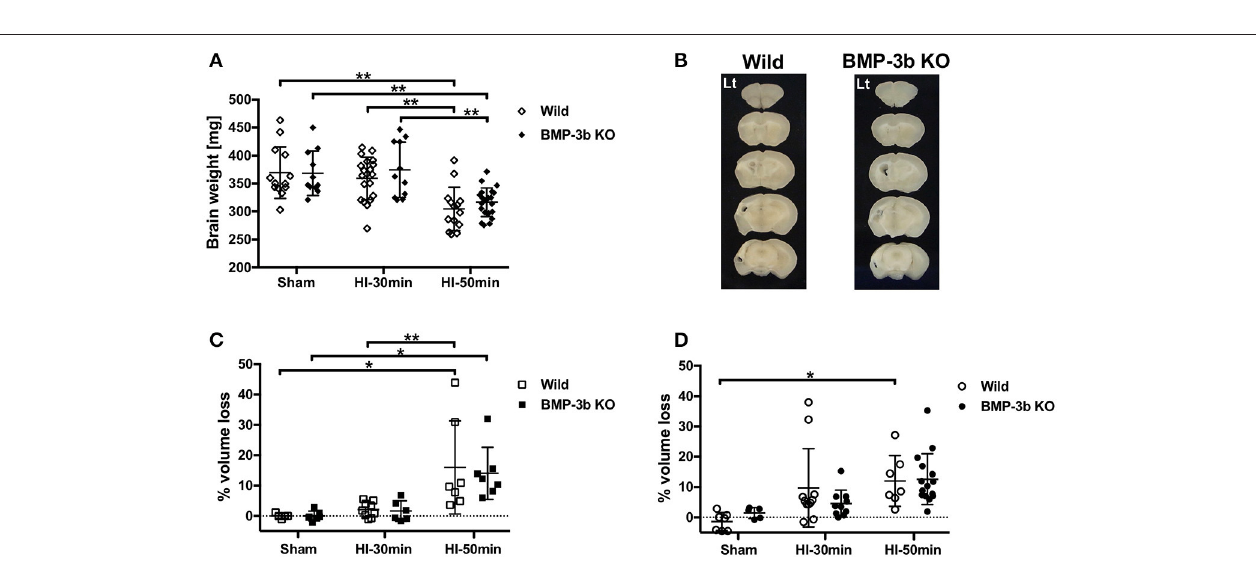
FIGURE 6 | (A) Brain weights at 14 days after surgery. (B) Representative images of 1-mm slices of brains after HI-50min insult at 14 days after the surgery. (C,D) Percent cerebral hemispheric volume loss: 100 × (contralateral hemispheric volume—ipsilateral hemispheric volume)/contralateral hemispheric volume. Males: (C) , females: (D) . * p < 0.05, ** p <